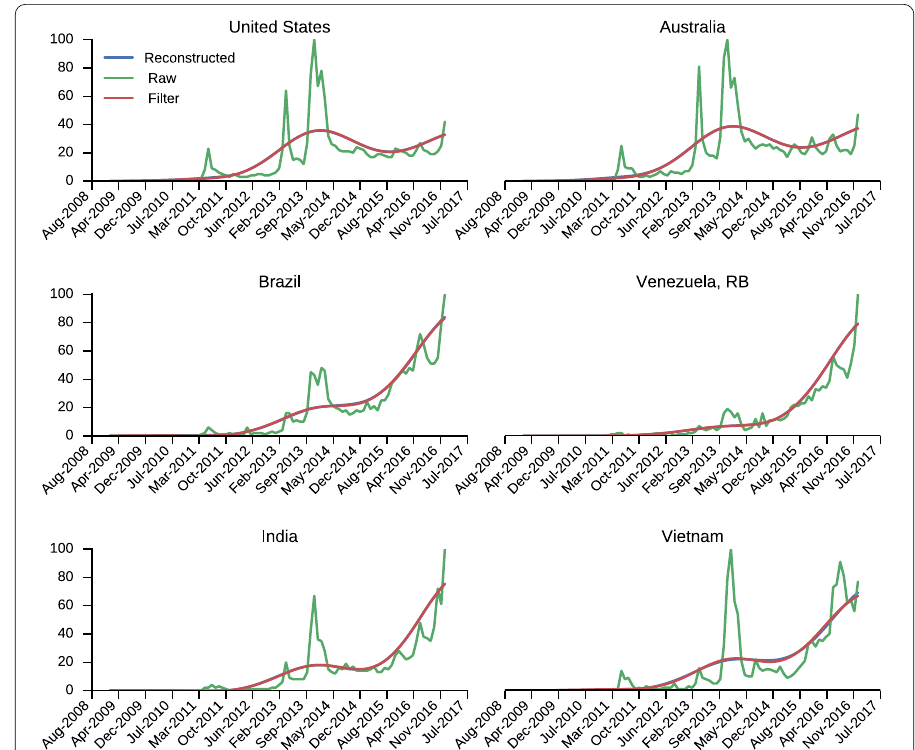
Figure 6 Google Trends time series, original, filtered and reconstructed for 6 countries. For each country we plot: the raw values from Google Trends (green), the filtered trend (red), and the reconstructed trend after the NMF (blue). In the first row we show 2 examples of high developed countries (H) with fluctuating trends. In the second and third row we report examples of countries with upper middle (UM) and lower middle (LM) development index and a growing trend of adoption. The blue line is present but hidden under the red one due to the goodness of the approximation